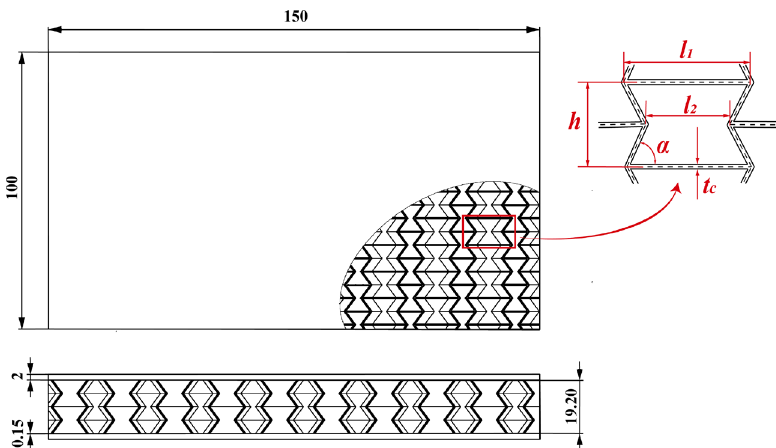
Figure 2. The schematic of the re-entering honeycomb sandwich panel.